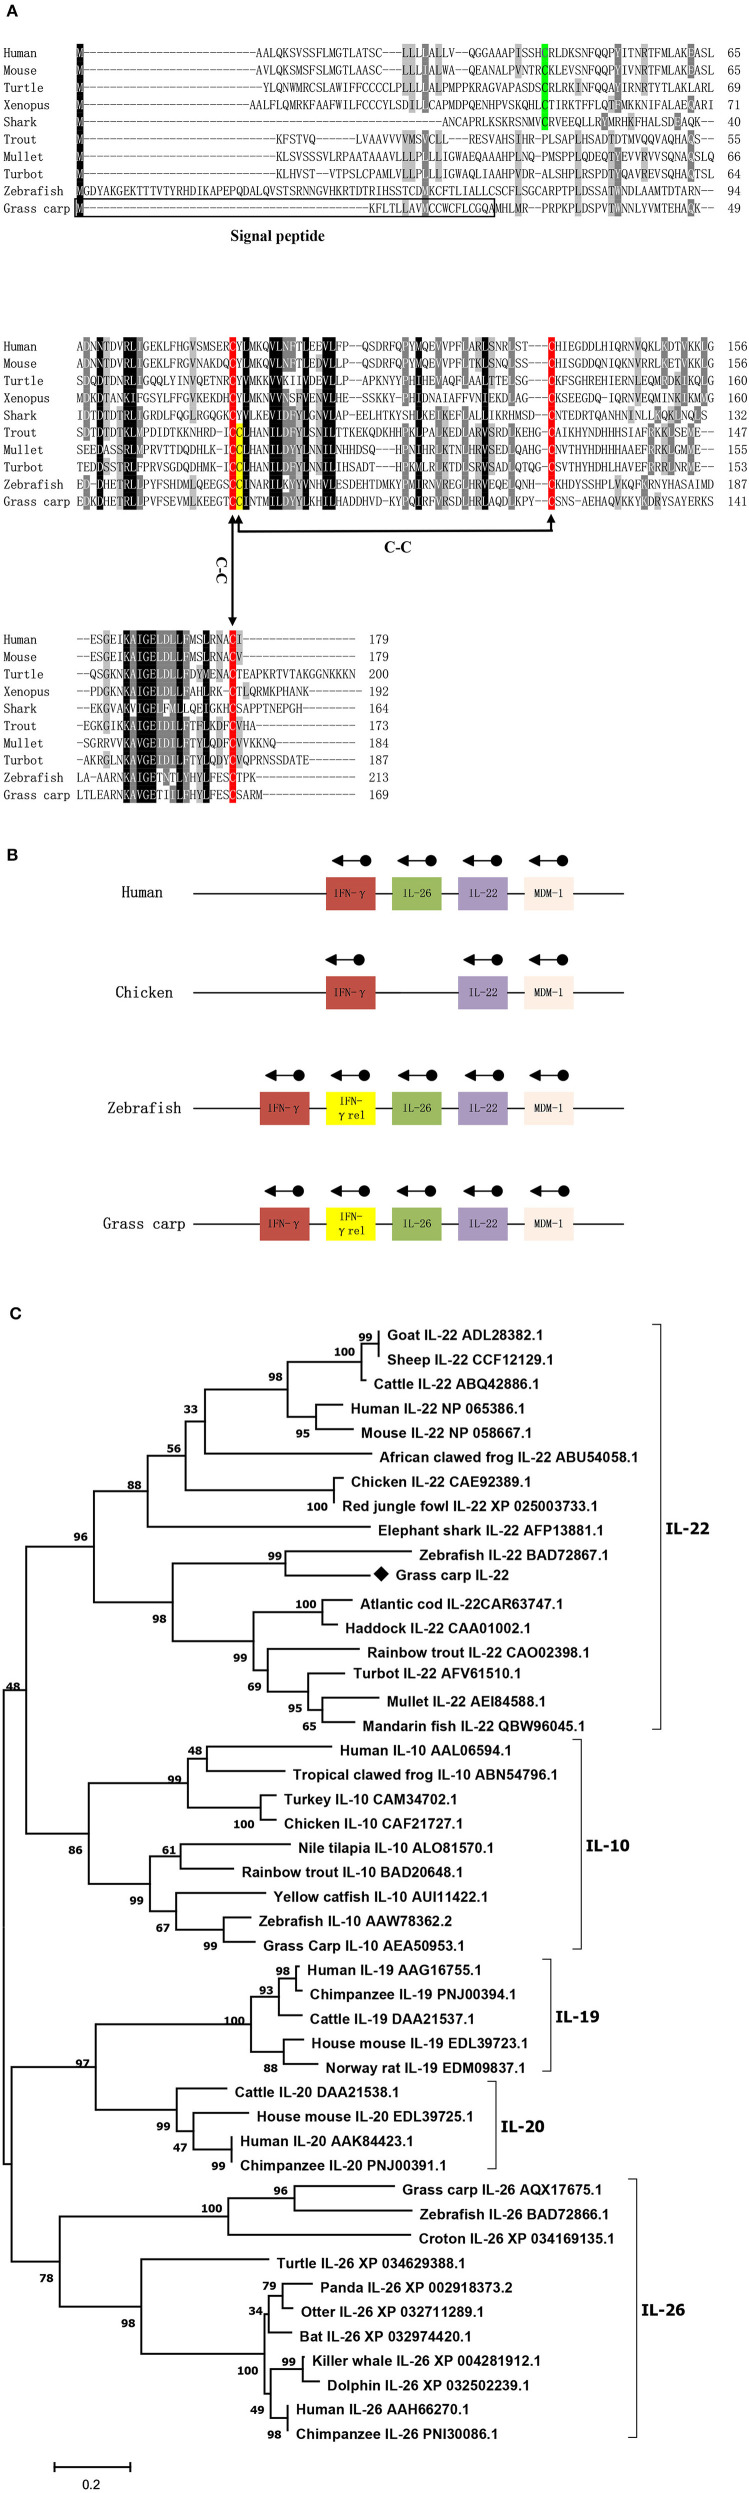
Protein sequence alignment (A), gene synteny (B), and the phylogenetic tree (C) of CiIL-22 and IL-10 family members. The predicted signal peptide is boxed, and putative disulfide bonds of CiIL-22 are indicated. Arrows indicate gene transcription orientation. The tree was constructed using the Neighbor-Joining method within the MEGA program (Version 6.0). The JTT matrix-based model using the pair-wise deletion option was chosen. The percentages of bootstrap values (>70%) are shown next to the branches based on 10,000 bootstrap replications. Protein sequences of IL-10 family members including IL-10, IL-19, IL-20, IL-22, and IL-26 were obtained from the NCBI database. The CiIL-22 is indicated by “♦”.